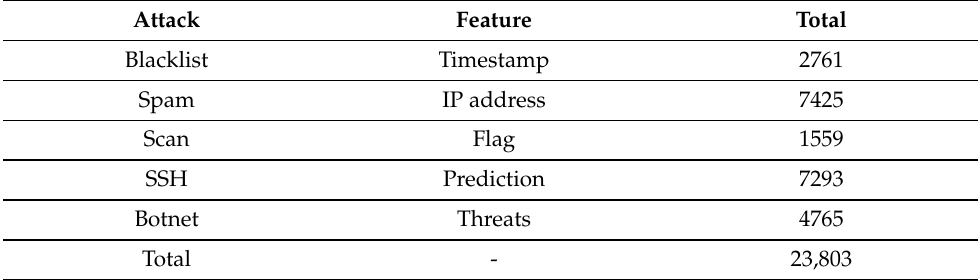
Table 2. The PCA results using the UGRansome.